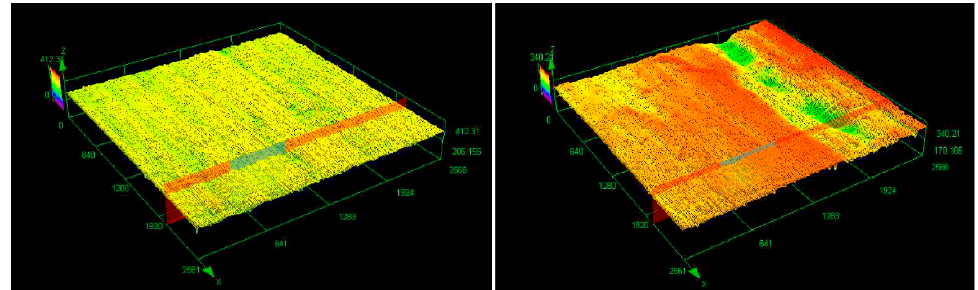
Figure 3. 3D image of black locust wood surface before ( left ) and after 2 years of weathering ( right )— confocal laser scanning microscopy (area of 800 × 800 μ m).